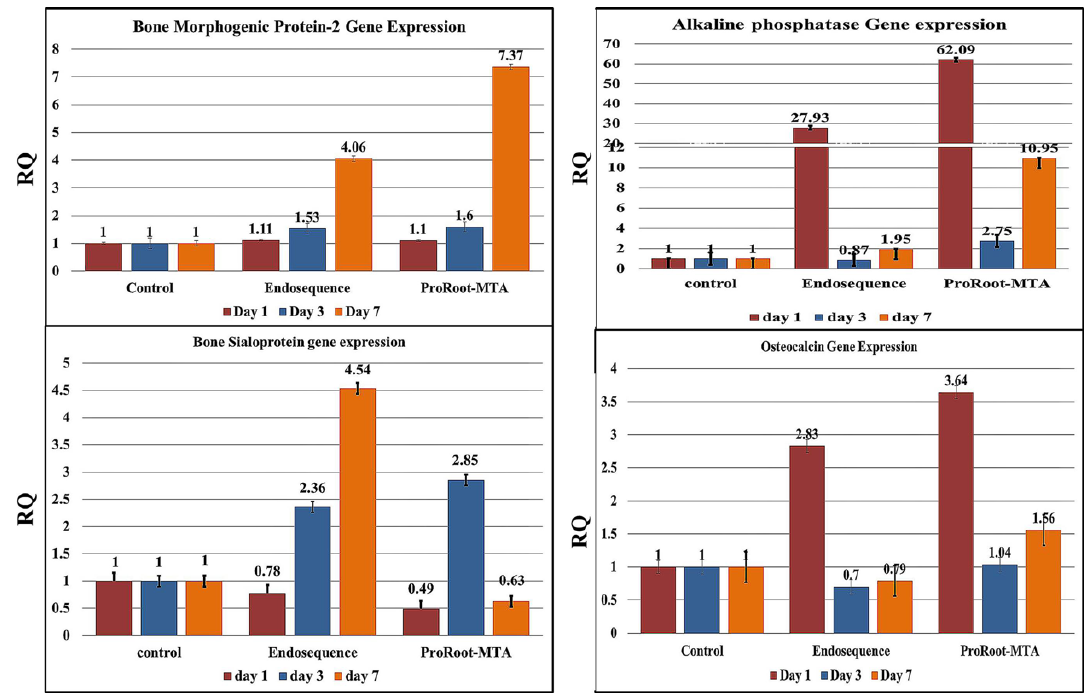
Figure 4. Relative quantification graphs of the ∆∆ CT values of the mRNA expression level of target genes, including BMP-2, alkaline phosphatase, bone sialoprotein, and osteocalcin, after treatment with material extracts compared to control untreated mesenchymal stem cells at p < 0.05. The relative quantification of control cells was normalized to 1. The relative quantification (RQ) values of treated cells that are greater than 1 indicate upregulation, and values less than 1 indicate downregulation.